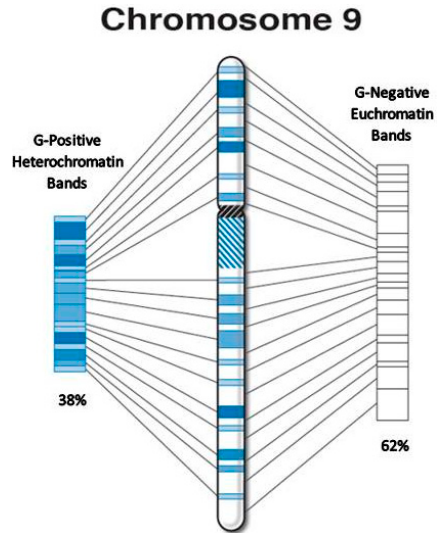
Figure 2. Sample stacked chromosome ideogram.